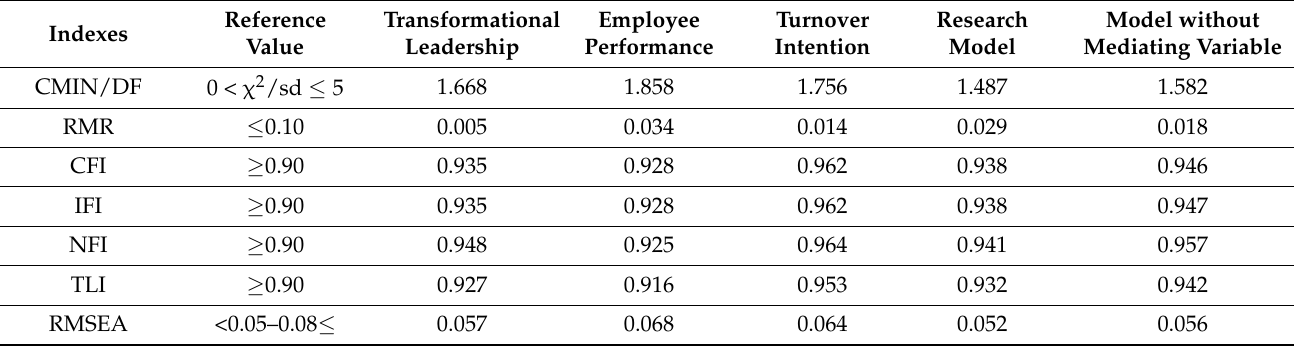
Table 1. The fit index